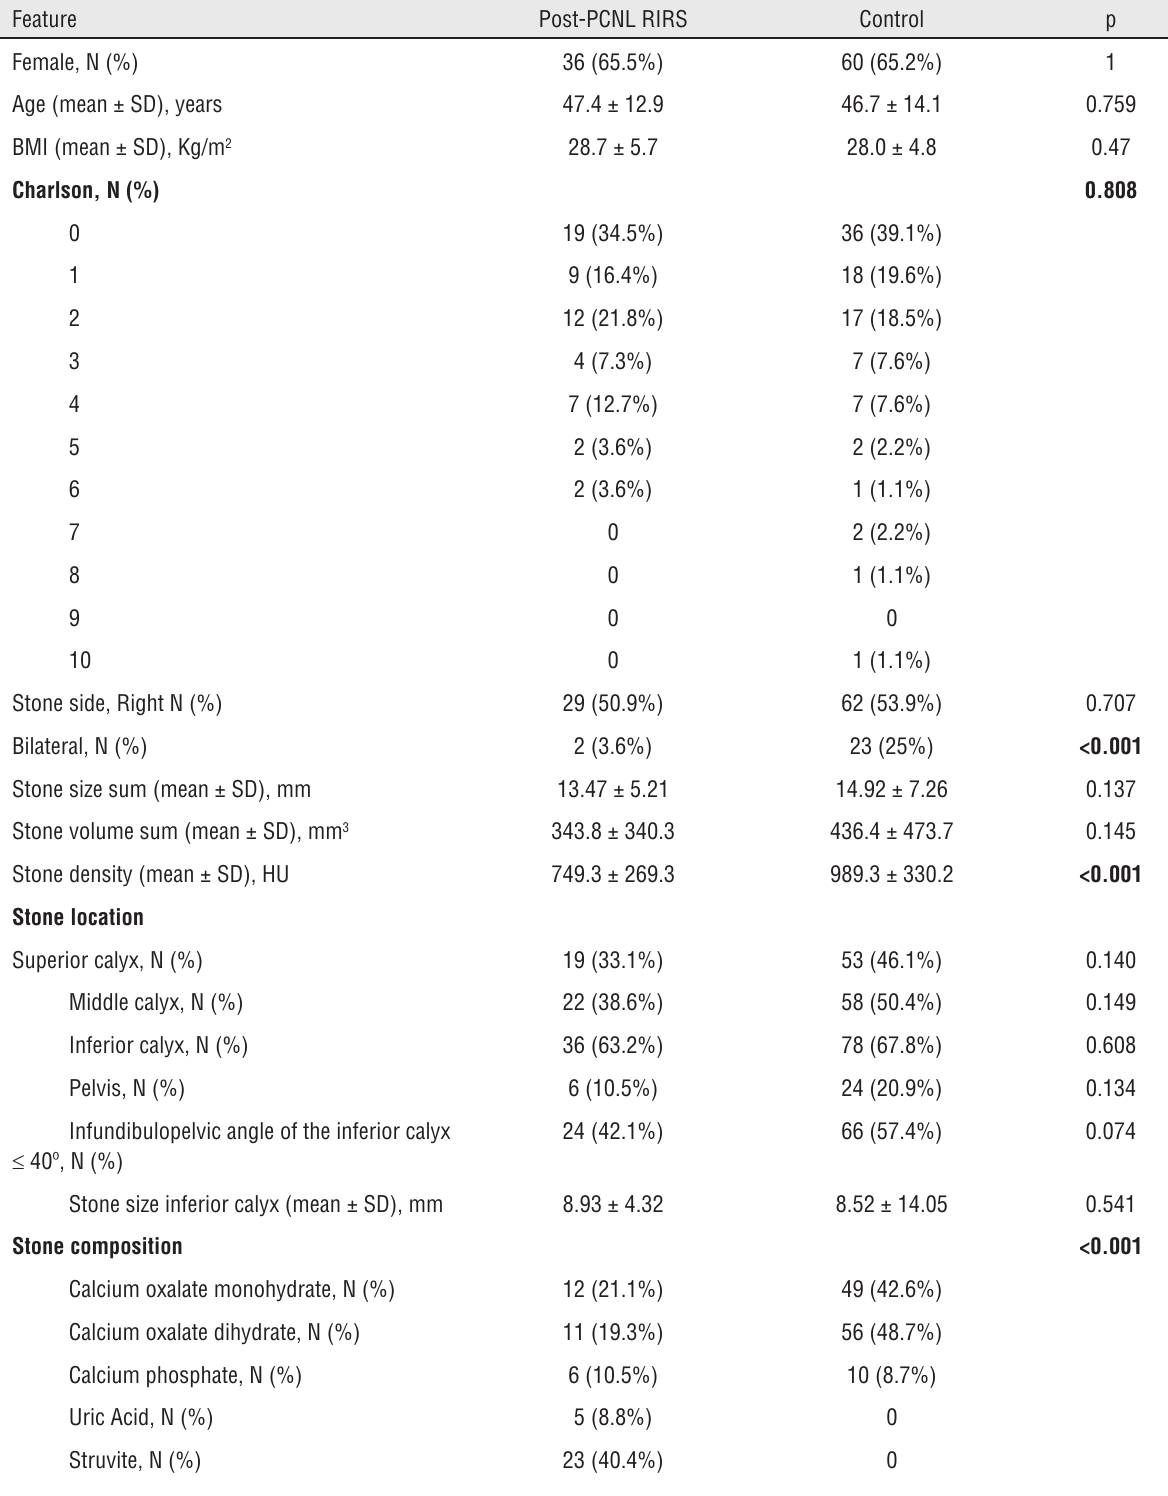
Table 1 - Clinical features of post PCNL RIRS vs.